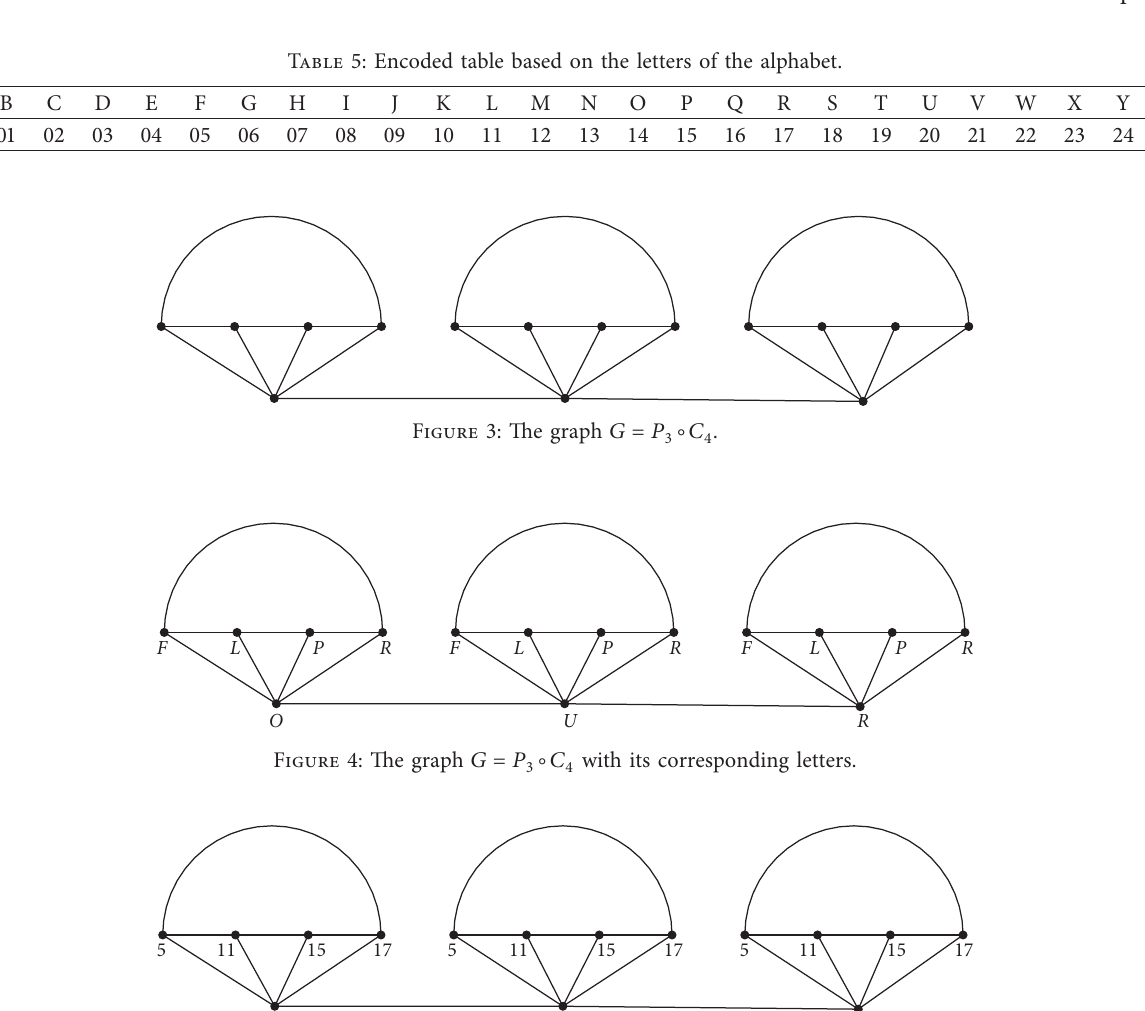
∘ C with its equivalent numerical values. 3 4